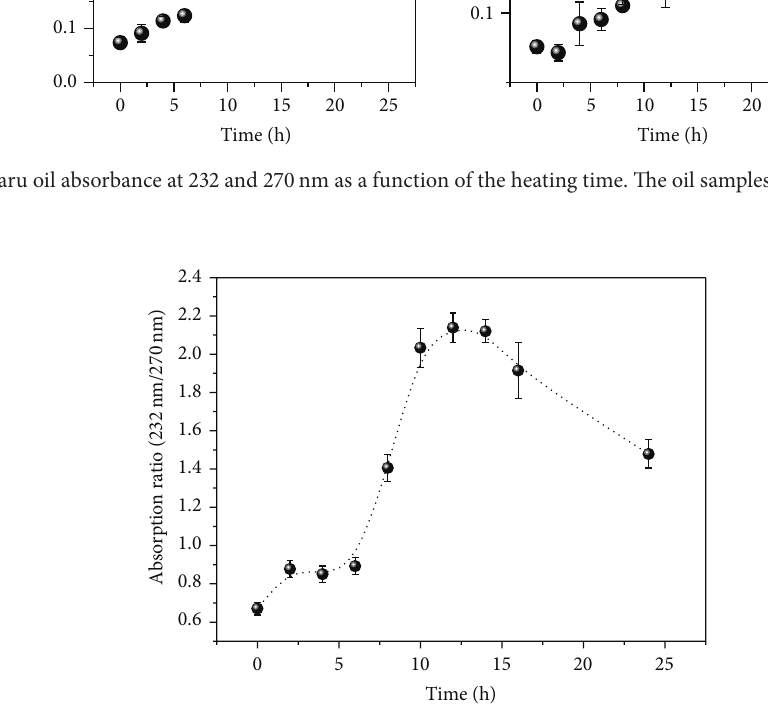
Figure 4: Baru oil absorption ratio at 232 to 270 nm as a function of the heating